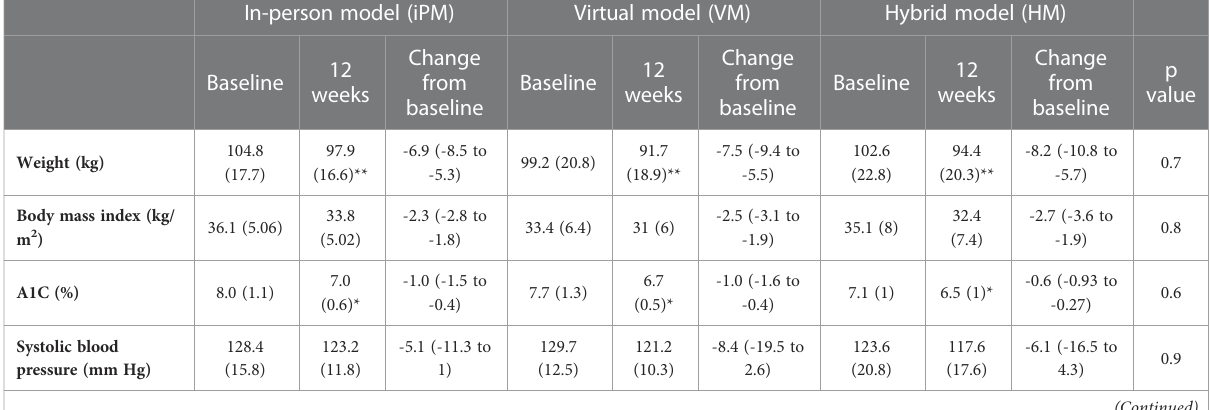
TABLE 2 Changes in metabolic and cardiovascular risk factors after 12 weeks of intensive lifestyle intervention in real-world clinical